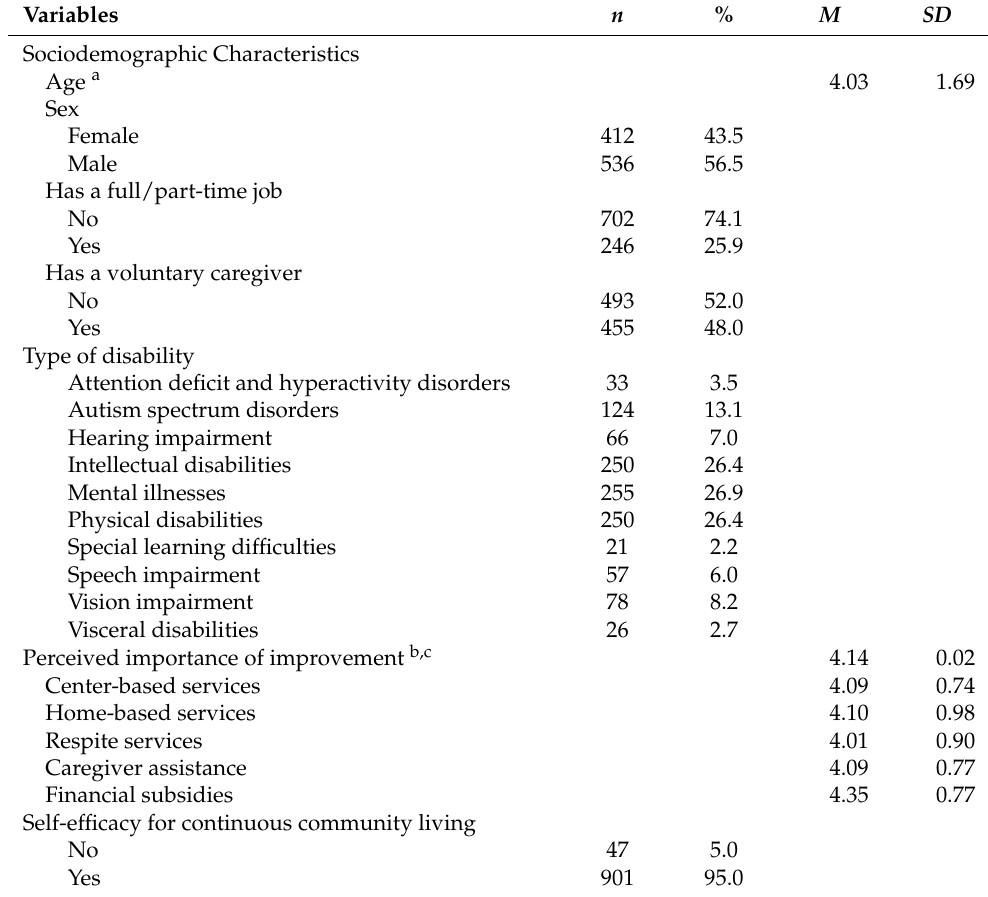
Table 2. The characteristics of individuals with disabilities in our sample ( n =